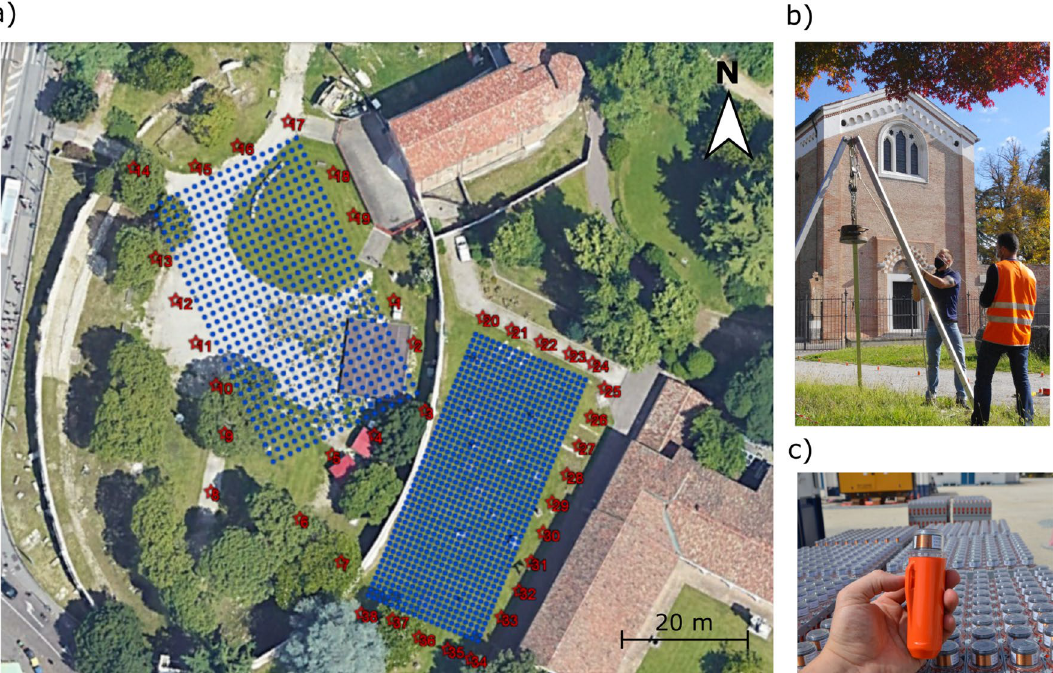
Figure 1. ( a ) Acquisition scheme for the 3D active/passive campaign. The blue points represent the locations of the autonomous seismic nodes, the red stars the locations of the active seismic sources. Note the well-preserved elliptical wall of the amphitheater and the Scrovegni Chapel on the Northern-Eastern side. ( b ) Weight drop source operating in front of the Scrovegni Chapel. ( c ) Autonomous seismic nodes used for the